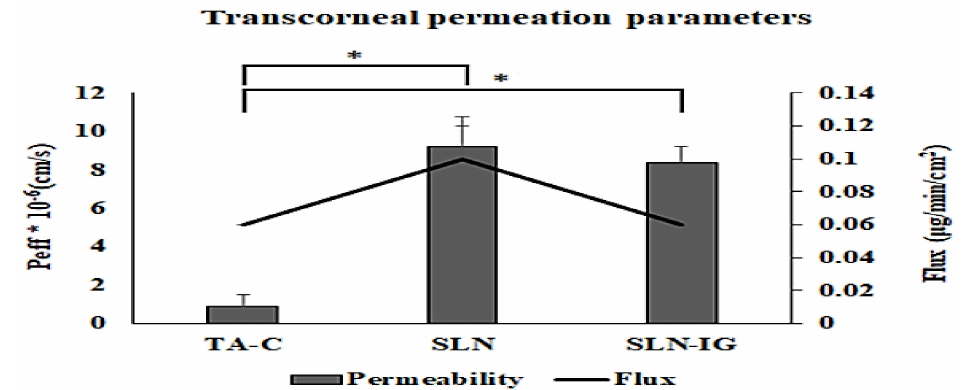
Figure 3. Transcorneal permeability profiles of TA from TA-SLNs (F5), TA-SLN-IG (F13), and TA-C through rabbit cornea (mean ± SD, n=3).